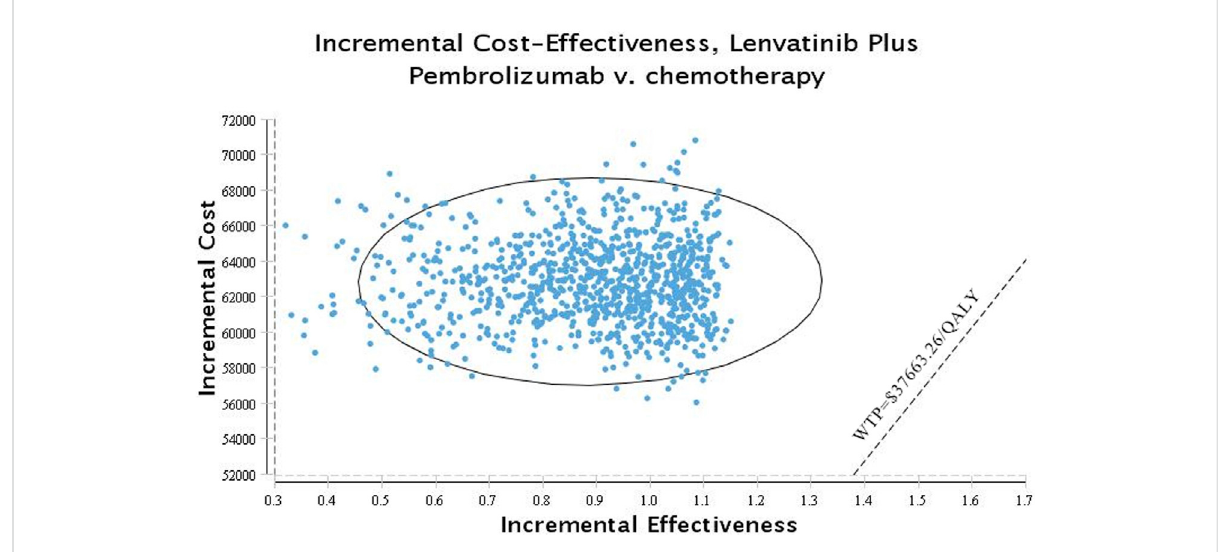
FIGURE 4 Scatter plot probabilistic scatter plot of the ICER between the lenvatinib plus pembrolizumab group and chemotherapy